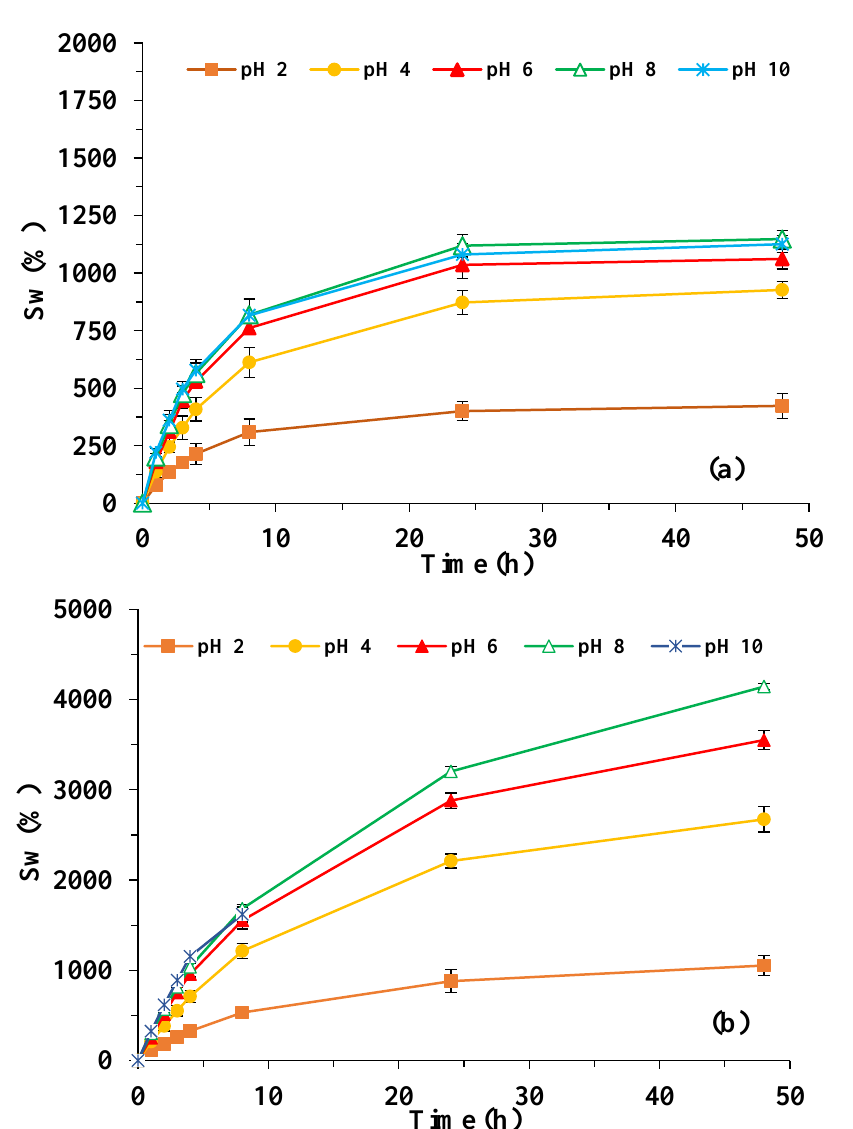
Figure 4. Swelling kinetic curves for ( a ) H-NMBA and ( b ) H-EGDMA systems at different pH.